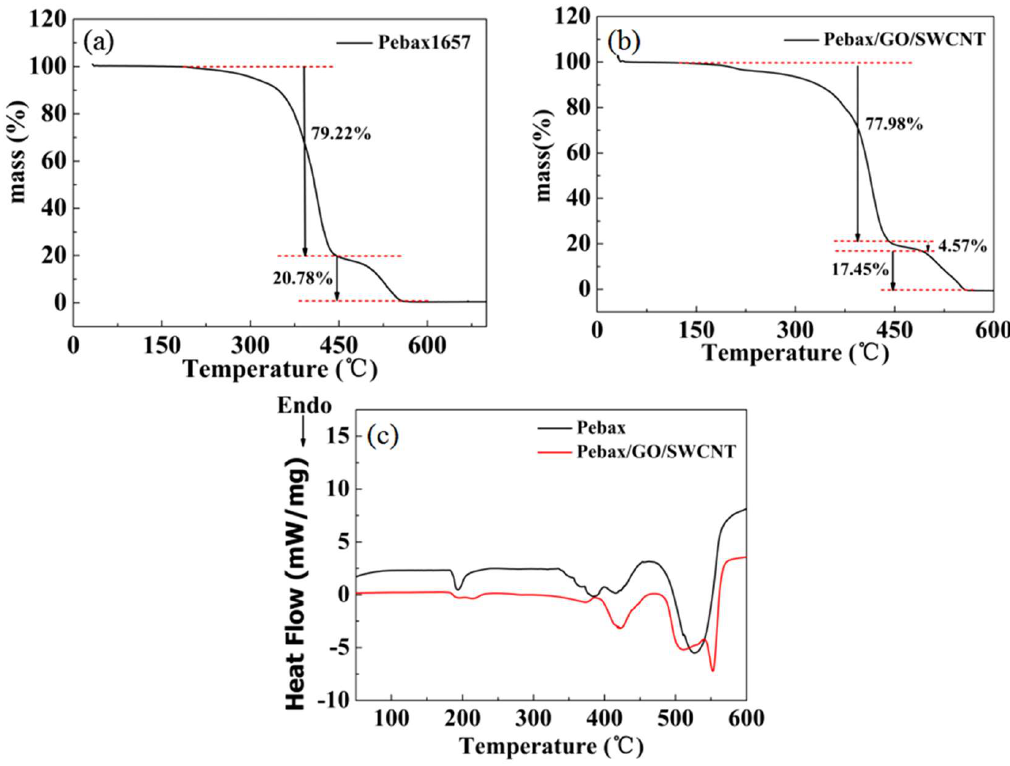
Figure 7. TGA of ( a ) pure Pebax1657, ( b ) GO/SWCNTs/Pebax1657 membranes, DSCof ( c ) pristine Pebax and Pebax/GO/SWCNT